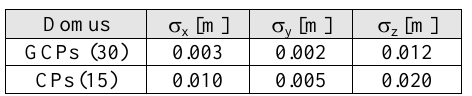
Table 2. Estimated precision and accuracy of the highest photogrammetric block